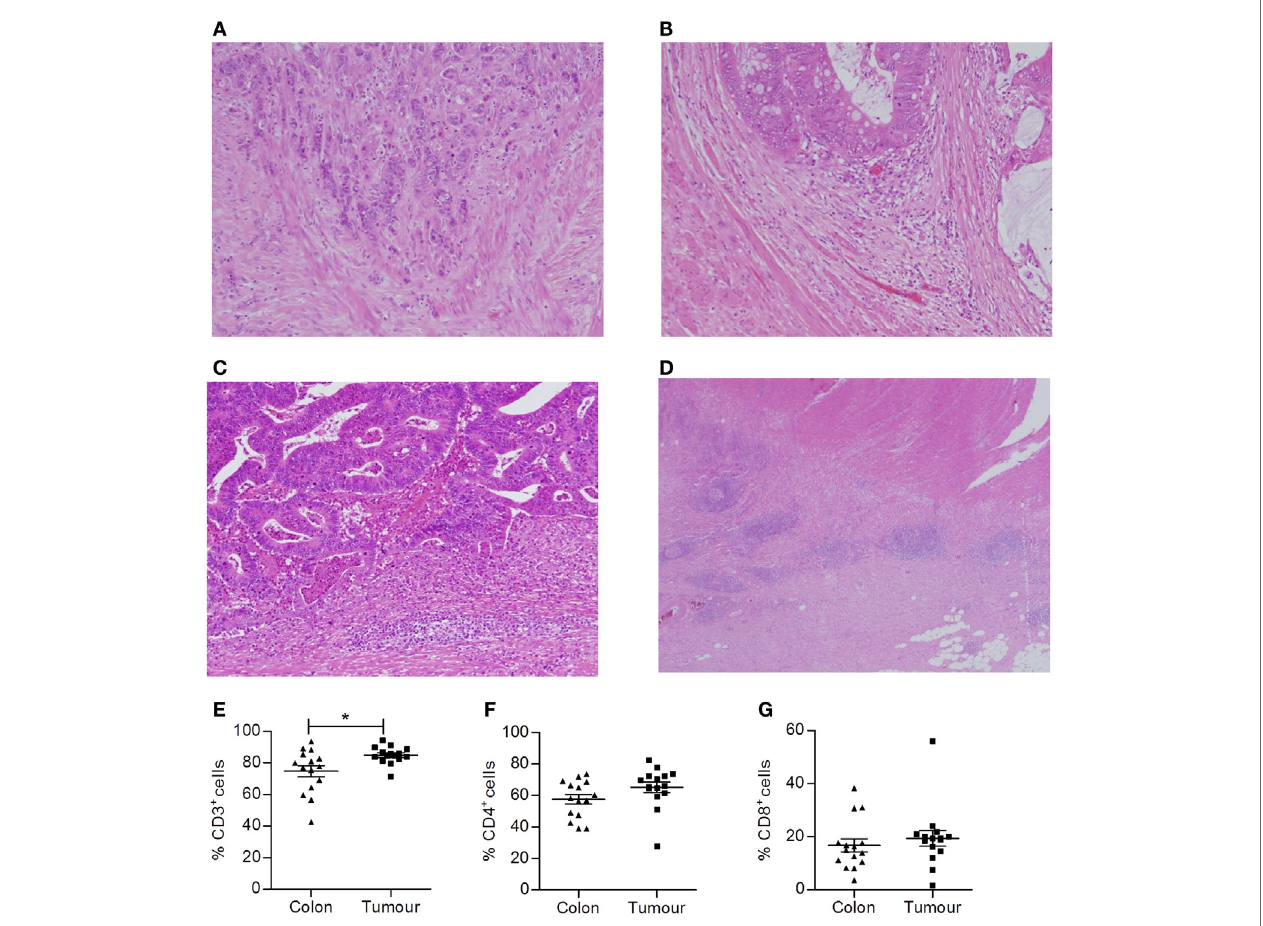
FigUre 1 | colorectal tumors are highly infiltrated with T cells . Representative H&E slides of colorectal tumors with varying KM scores. (a) KM score 0, (B) KM score 1, (c) KM score 2, and (D) Crohn’s-like reaction. Single cell suspensions were also obtained by enzymatic digestion from surgically excised normal adjacent colonic tissue and colorectal tumors. The frequency of CD3 + (e) , CD4 + (CD3 + CD8 − ) (F) , and CD8 + (g) T cells within lymphocytes was determined by flow cytometry. * p < 0.05 as determined by the Wilcoxon signed rank